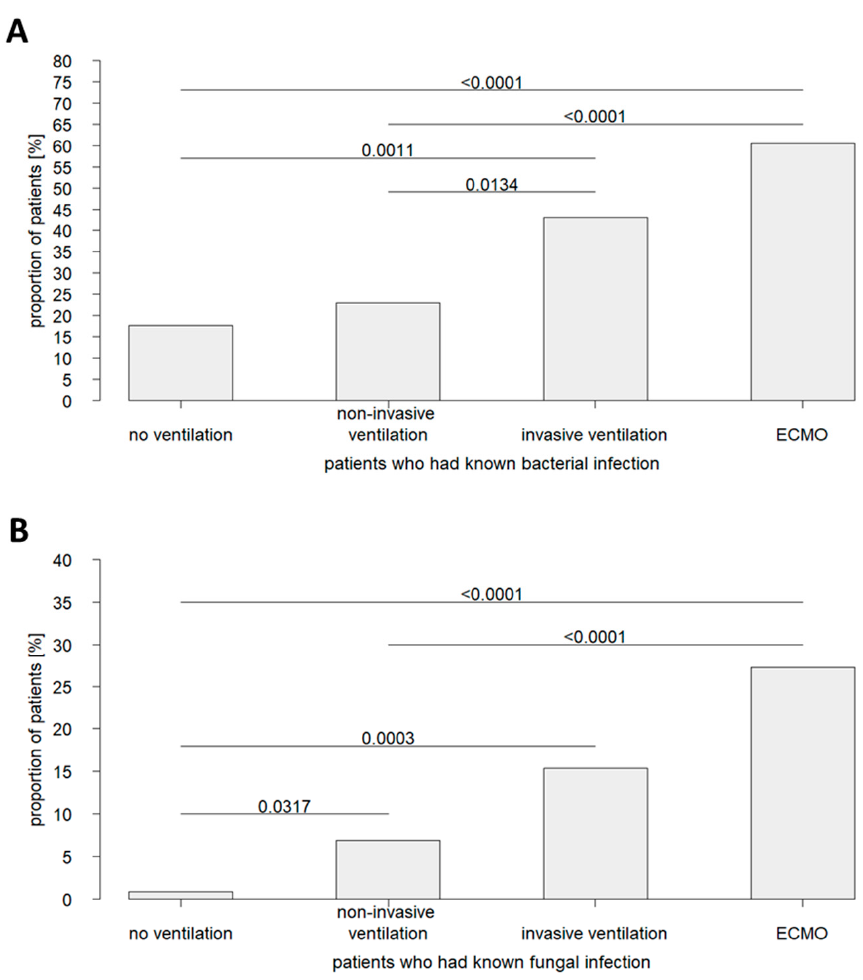
Figure 3. Prevalence of secondary infections in patients critically ill with COVID-19 who received no ventilation therapy or were treated with non-invasive ventilation, invasive ventilation, or ECMO. Shown are the proportions of patients with ( A ) bacterial and ( B ) fungal infections of nosocomial